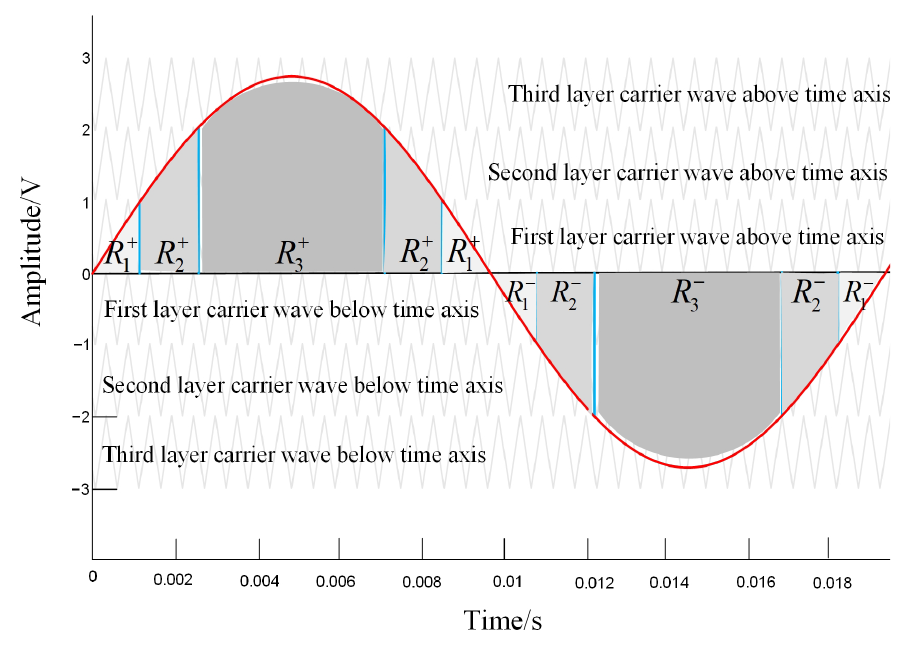
Figure 7. Division of time regions.